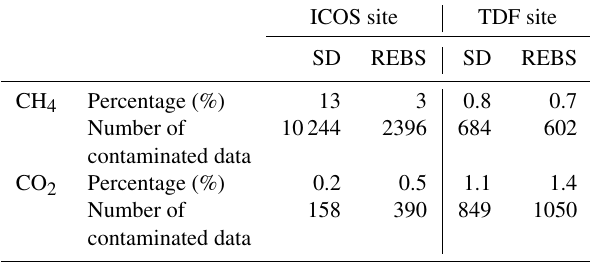
Table 5. Percentages and number of contaminated data detected by SD and REBS methods for CO 2 and CH 4 at